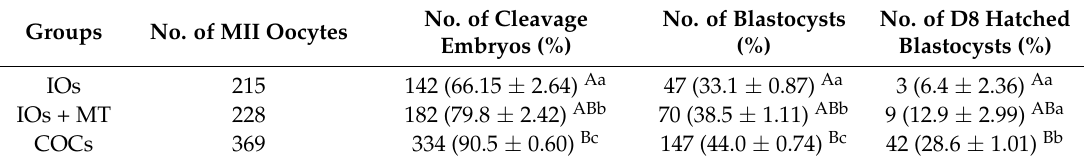
Figure 6. Relative expression levels of BMP-15, GDF-9, ATPase 6 and ATPase 8 in MII oocytes. a–c Values of different superscripts indicate significant difference within the expression level of each gene ( p < 0.05). COCs, cumulus–oocyte complexes; IOs, inferior bovine oocytes; MT, melatonin. Table 2. The effect of melatonin on IVF Embryo Developmental potential of oocytes.